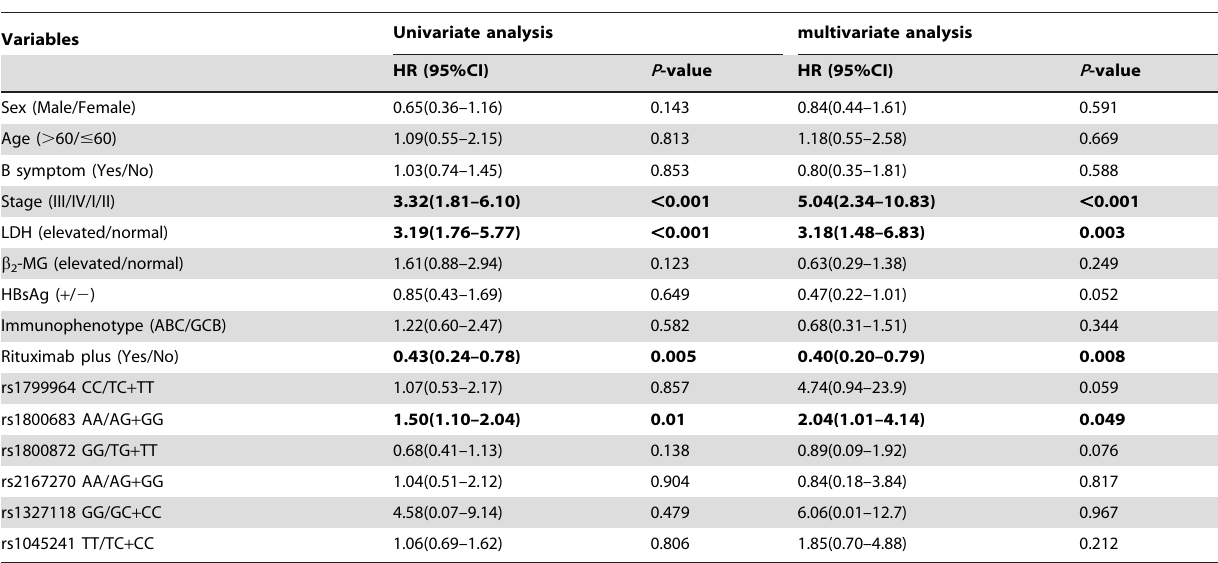
Table 2. Univariate and multivariate analysis for PFS in DLBCL cases.